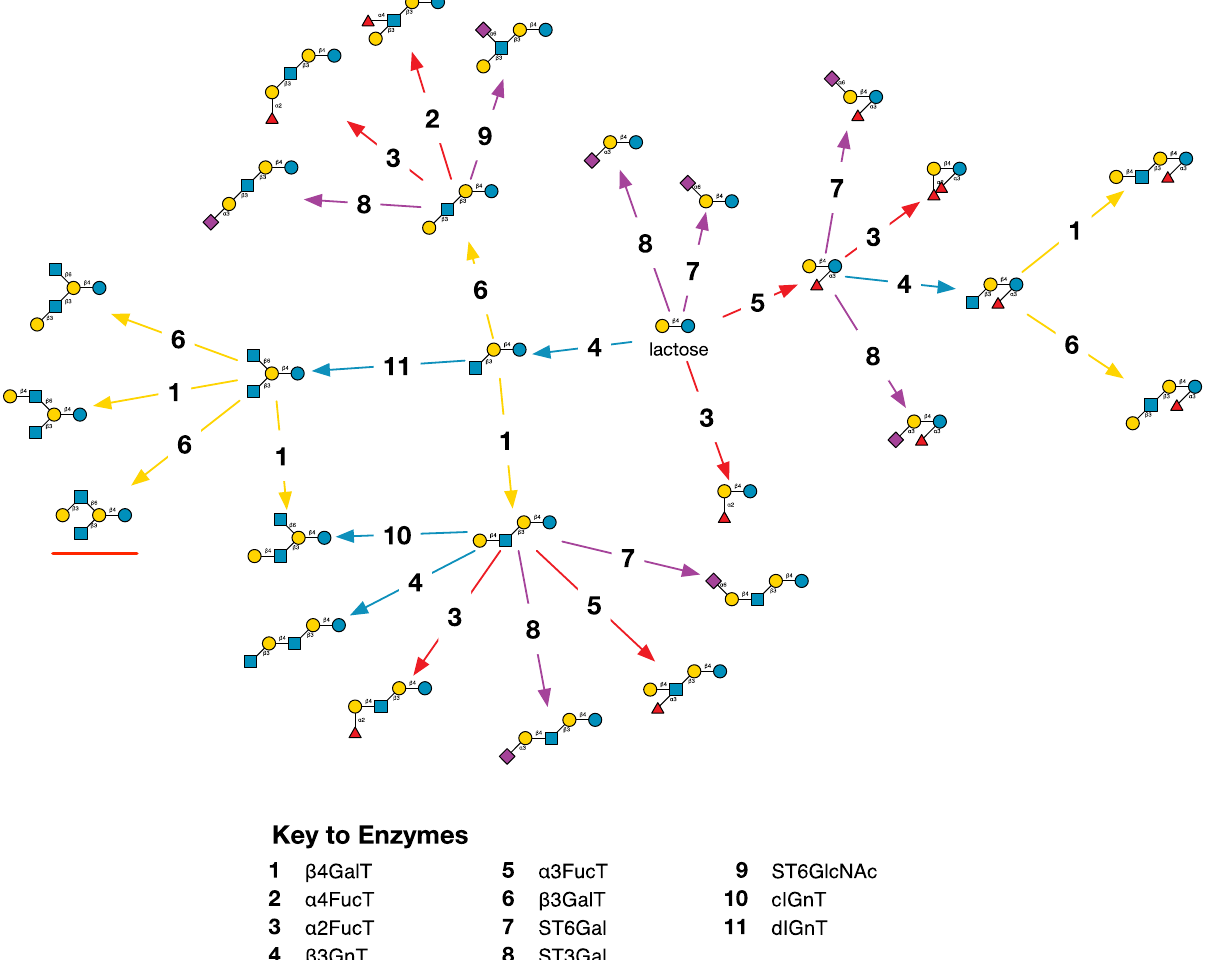
Figure 2. Reactions of the model. A reaction network generated by three iterations of the enzyme simulator, starting from lactose. Enzymes reactions are represented arrows leading from an acceptor substrate to an acceptor product, coloured according to the type of monosaccharide transferred: GlcNAc (blue), Gal (yellow), Fuc (red), Neu5Ac (purple). For simplicity, donor substrates and nucleotide products are omitted. The structure underlined in red was not found among the observational data set (Supplementary Table